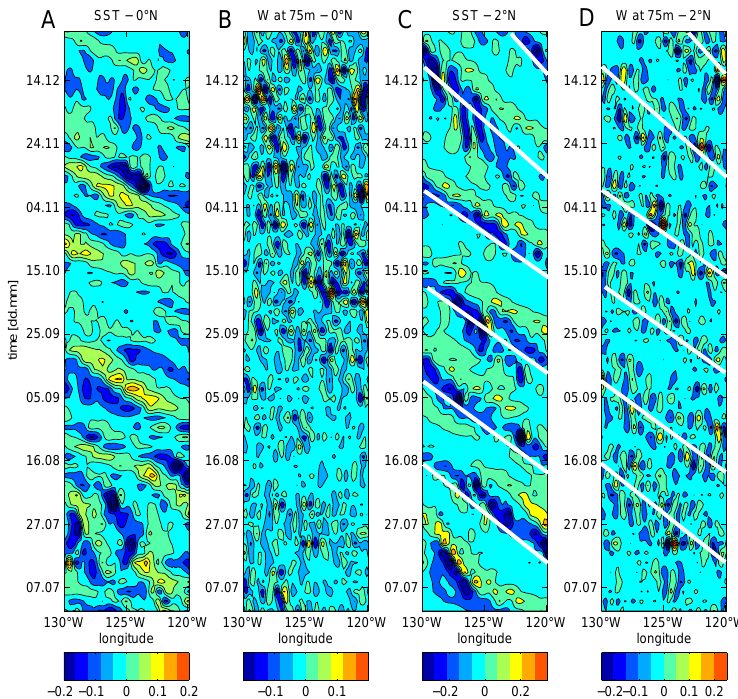
Fig. 7. Time–longitude diagrams of filtered (20–35day period) ROMS–CoSiNE model fields of: (A) SST and (B) w at 0 ◦ N, and (C) SST and (D) w at 2 ◦ N. Time period is from June 2004 to December 2004. Yellow and orange areas correspond to positive, and dark blue areas to maximum negative variability in the TIW-active period domain. Westward passing wave features in the fields at 2 ◦ N are identified as TIWs I to VI (from earliest to latest) and their approximate tracks are marked with white lines.